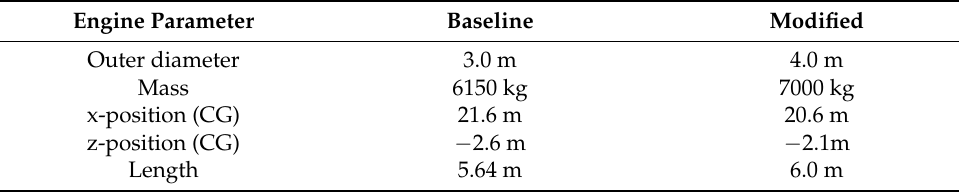
Figure 3. Visualization of the engine’s outer shape—baseline left; modified right. Table 2. Parameters of the engine